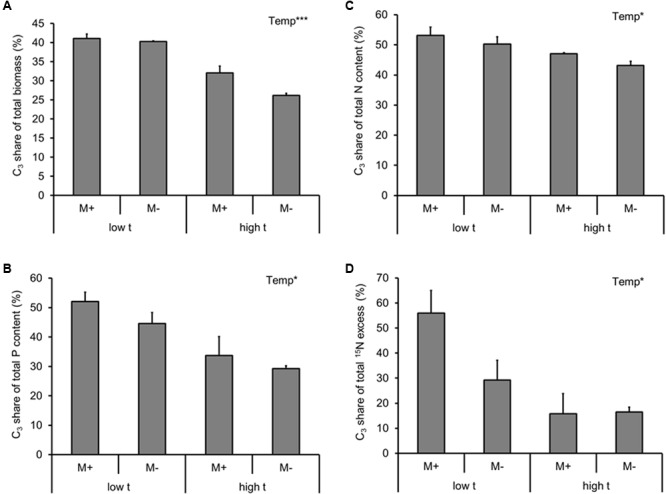
Fraction of dry biomass (A), phosphorus (P) content (B), nitrogen (N) content (C) of the experimental plants (shoot and roots combined), and the 15N excess (i.e., 15N derived from the isotopically labeled clover biomass added to the RFC), (D) detected in the plant biomass (shoot and roots combined) per cultivation container assignable to the C3 plant (i.e., the share of resources diverted to the C3 plant on a whole cultivation container basis, with the remaining part of the particular resource being assignable to the C4 species) as affected by mycorrhizal inoculation (M+, mycorrhizal inoculum added; M-, non-mycorrhizal control) and cultivation temperature (low t, 25°C during daytime; high t, 36°C during daytime) for the mixed cultures. Mean values ± standard errors are shown (n = 4 for M+ high t treatment, n = 3 for all the other treatments). Significances of inoculation, cultivation temperature (Temp), and their interaction are indicated (factors with p ≥ 0.05 are not shown, ∗∗∗p < 0.001, ∗0.01 ≤p < 0.05).